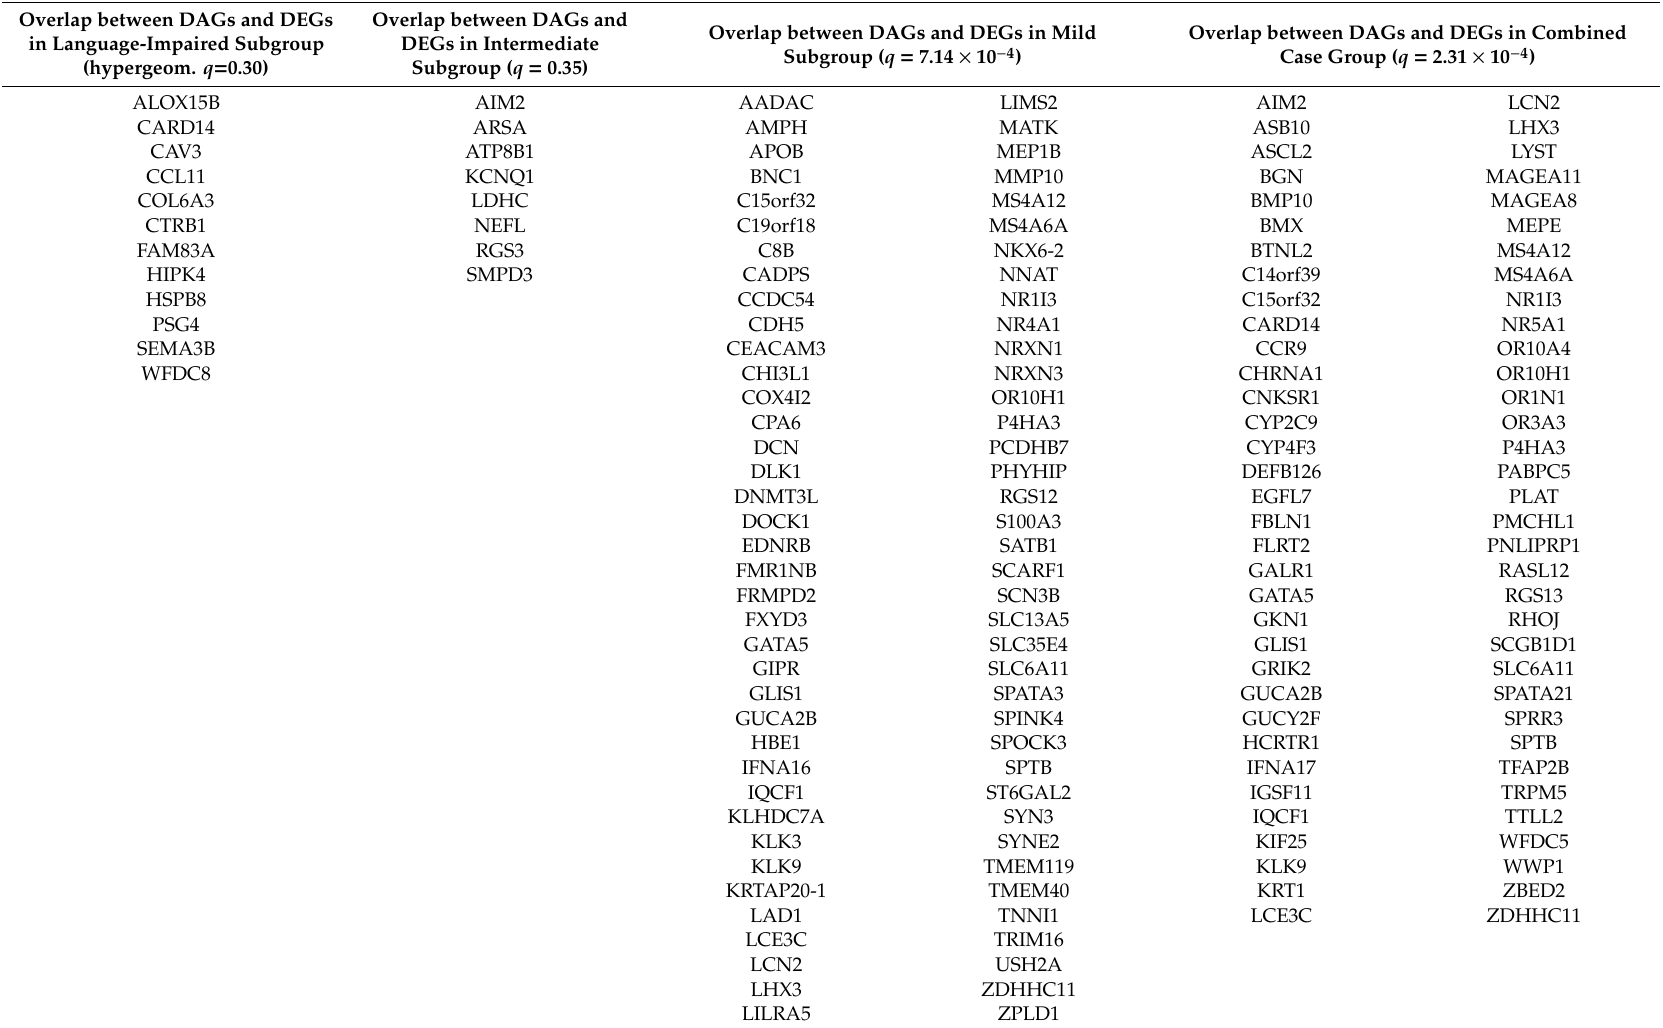
Table 7. Overlapping genes among DAGs and Di ff erentially Expressed Genes (DEGs) from the three phenotypic subgroups of ASD and the combined case group. Overlap between DAGs and DEGs in Language-Impaired Subgroup (hypergeom. q =